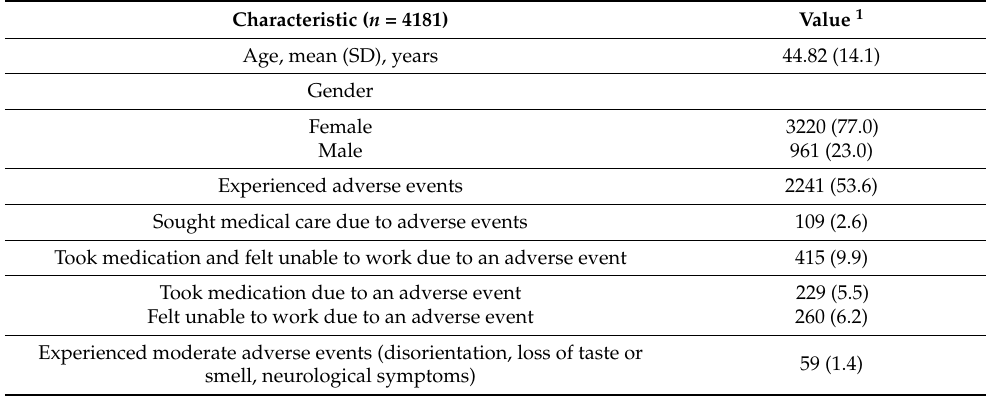
Table 1. Characteristics of study participants and experienced adverse events in the first 21 days after the first dose of Comirnaty (Pfizes-BioNtech) vaccine.